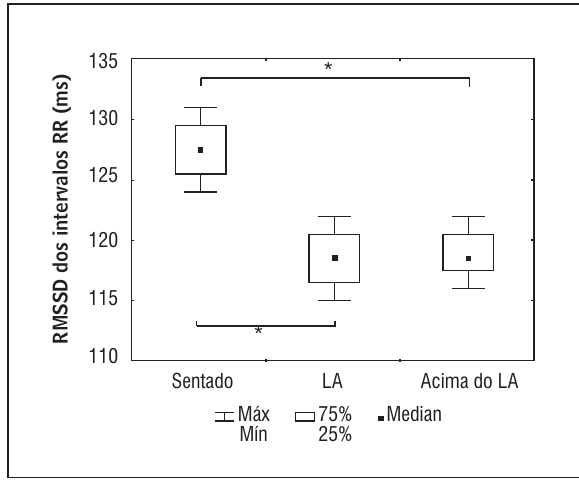
Figura 3 - Valores dos índices RMSM (ms) obtido em repou- so sentado e nas velocidades do LA e acima do